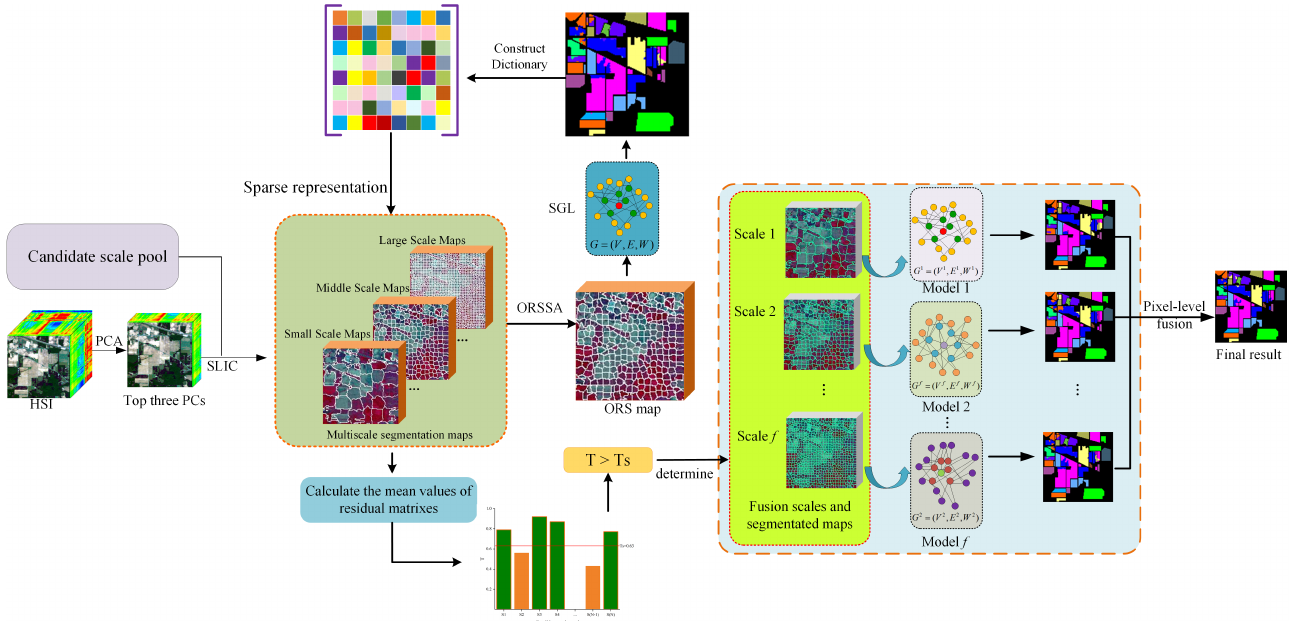
Figure 1. The flowchart of the proposed MSGLAMS method. PCA: principal component (PC) analysis; SLIC: simple linear iterative clustering; ORSSA: optimal reference scale (ORS) selection algorithm; SGL: superpixel graph